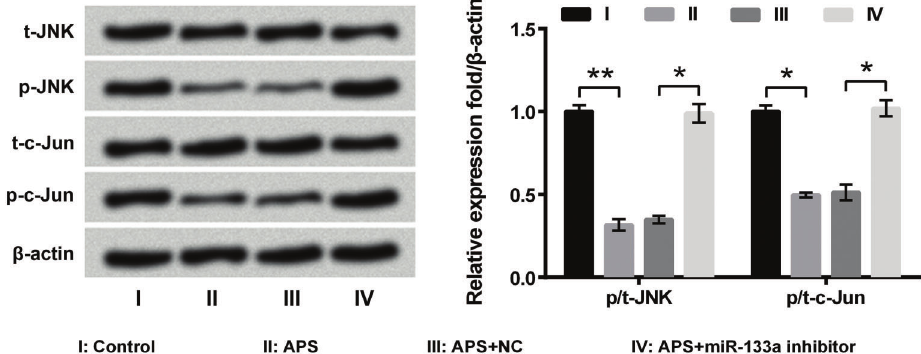
Figure 5. Astragalus polysaccharides (APS) inhibited JNK pathway through up-regulating miR-133a in MG63 cells. Transfected and non-transfected MG63 cells were stimulated with 10 mg/mL APS. Non-treated cells acted as control. Expression levels of proteins involved in the JNK pathway were assessed by western blot analysis. Data are reported as means ± SE of three independent experiments. *P o 0.05; **P o 0.01